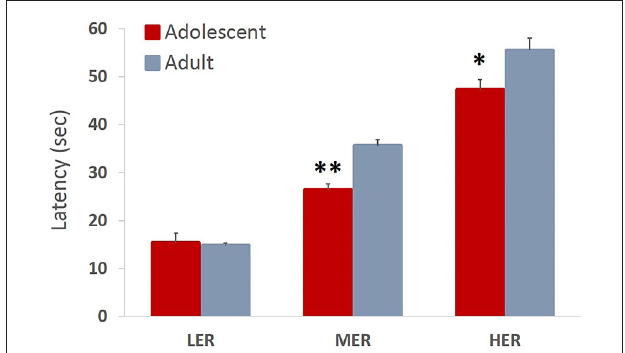
FIGURE 6 | Trial latencies in an effortful reward valuation task . Bar graphs represent average latency (sec) to complete the trial + SEM. Trial latencies increased with barrier height in both adolescent and adult animals. Adolescent animals were faster to complete MER and HER trials compared to adult group. * p < 0.05, ** p < 0.01.